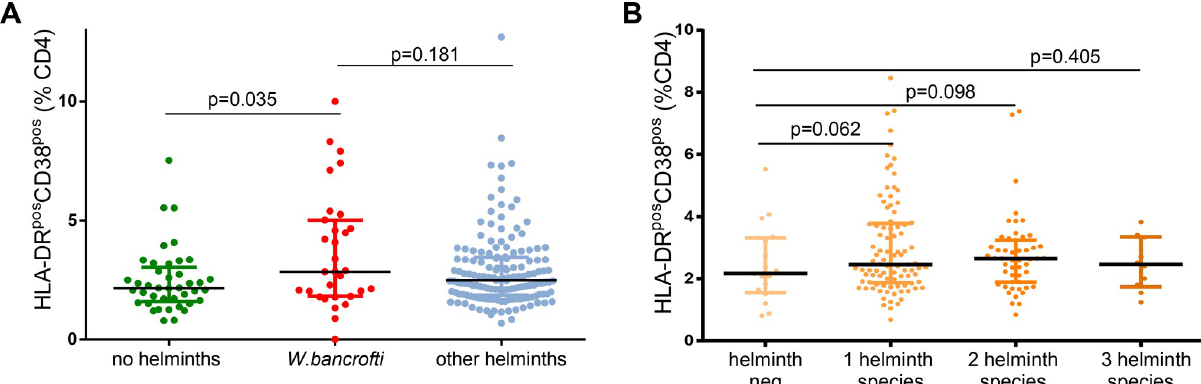
Fig 4. A: Association of helminth status with the frequency of HLA-DR pos CD38 pos CD4 T cells. The percentage of HLA-DR + CD38 + expressing CD4 T cells is shown for the three categories of participants. Kruskal-Wallis testing showed significant difference between groups overall (p = 0.044). A significant difference was seen between the subgroup of individuals without helminths and the W . bancrofti - infected participants (using Mann-Whitney testing). B: Association of polyparasitism with the frequency of HLA-DR + CD38 + CD4 T cells . The percentage of HLA-DR + CD38 + expressing CD4 T cells is shown for participants with increasing numbers of helminth species. Kruskal-Wallis testing showed no significant difference between groups (p = 0.262), as did the Mann-Whitney.